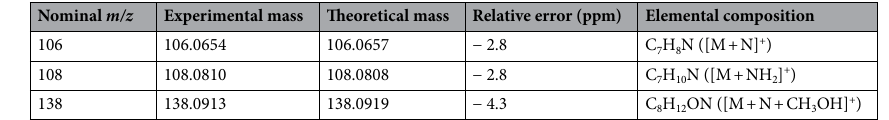
Table 1. High resolution APCI-( +)MS data of the unusual ions derived from toluene/methanol.